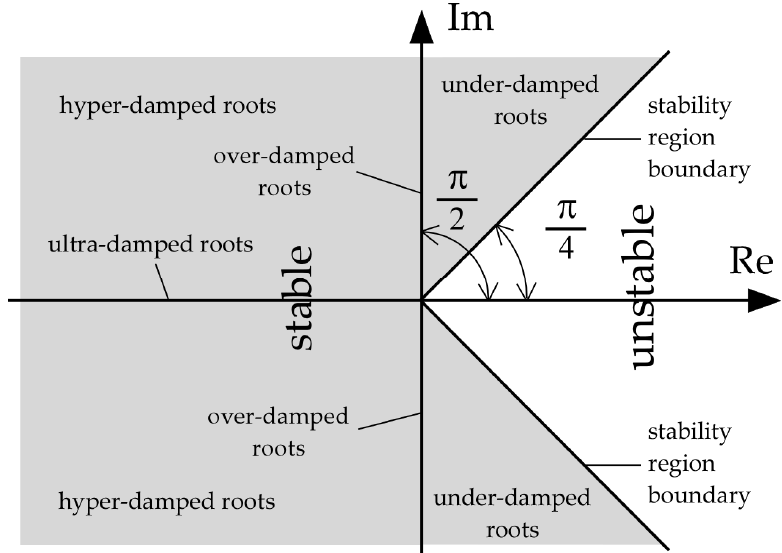
Figure 3. Stability regions of fractional order systems with fractional commensurate order q = 1/2.